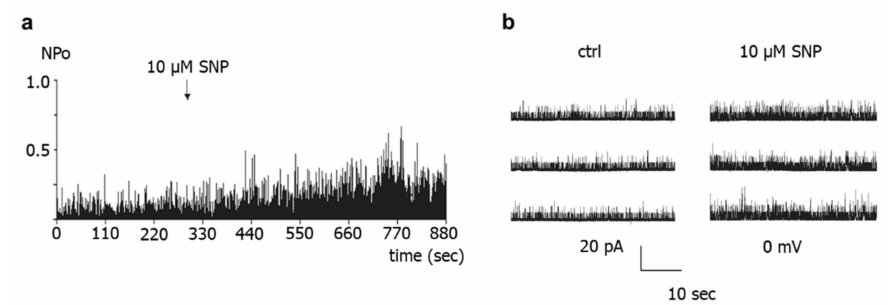
Figure 5. Effect of the NO-donor SNP on excised BK channels of rat tail artery smooth muscle cells. ( a ) Example of a diary plot of BK channel activity (NPo) at 0 mV with application of SNP (at arrow). ( b ) Examples of traces of BK channel activity at 0 mV taken from the same patch as in ( a ) during control (ctrl) and addition of SNP.